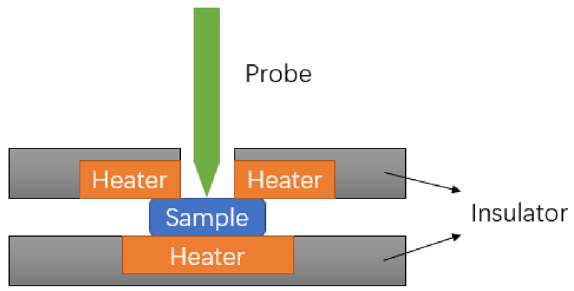
Figure 8. Schematic of the xSol Temperature Stage used in the TI 950 TriboIndenter systems which is capable of heating the sample from room temperature to 800 ◦ C.